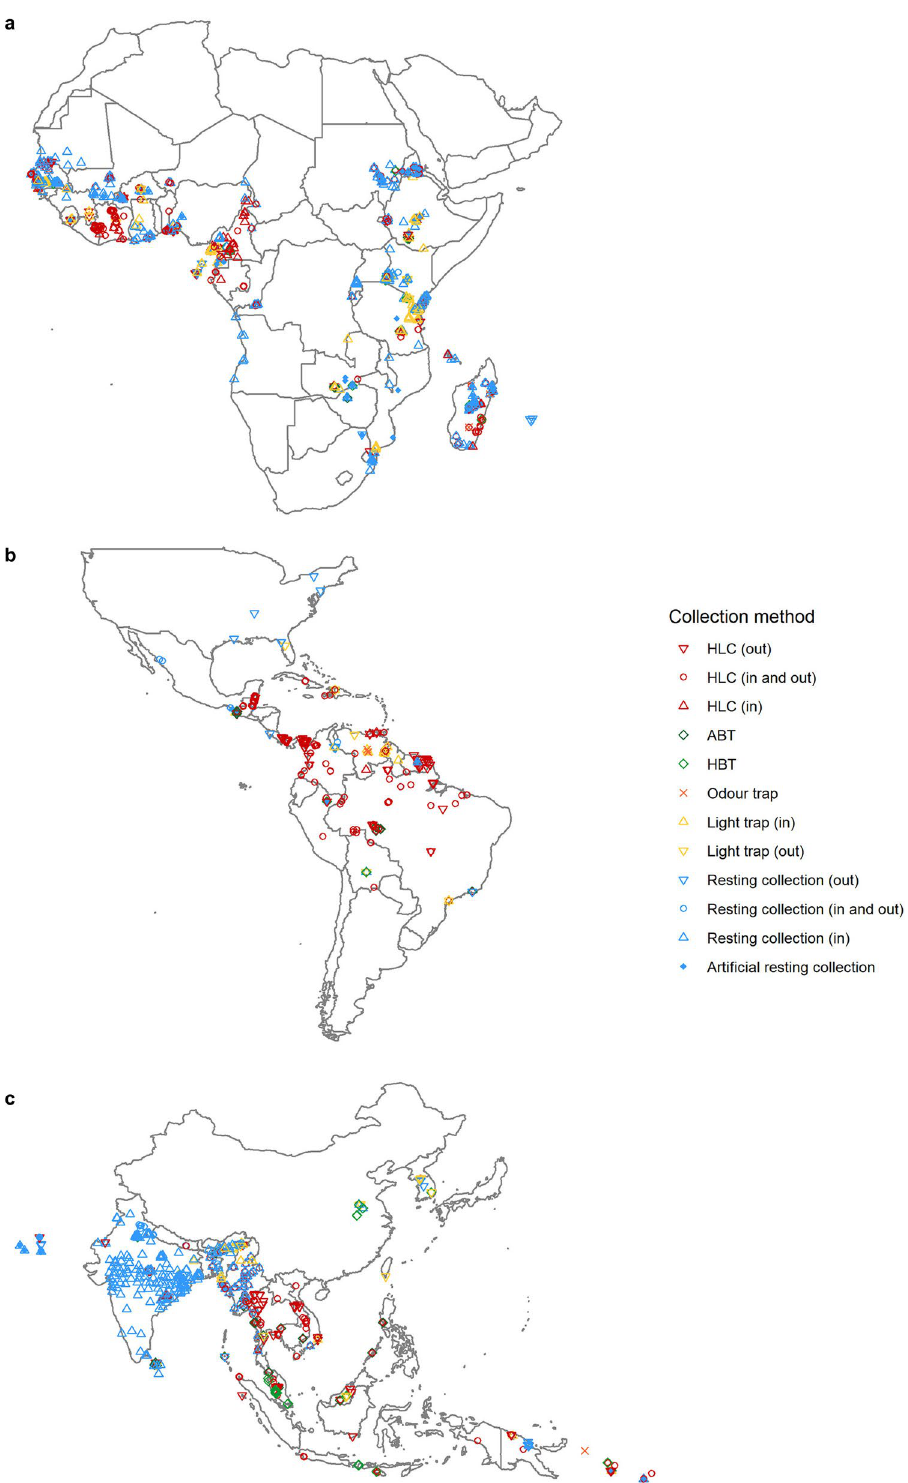
Figure 5. Geographical distributions. Geographical distribution of the different collection methods used in ( a ) Africa, ( b ) the Americas and ( c ) the Asia-Pacific region to collect malaria vectors. ABT = animal-baited trap, HLC = human landing catch, HBT = human-baited double net trap. Maps were made with R statistical software (R version 4.0.2), packages ‘tidyverse’ and ‘maps’ 45